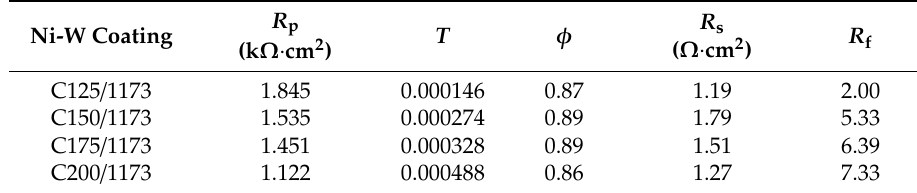
Table 3. EIS parameters determined for Ni-W coatings after heat treatment in the air, in dependence on deposition current